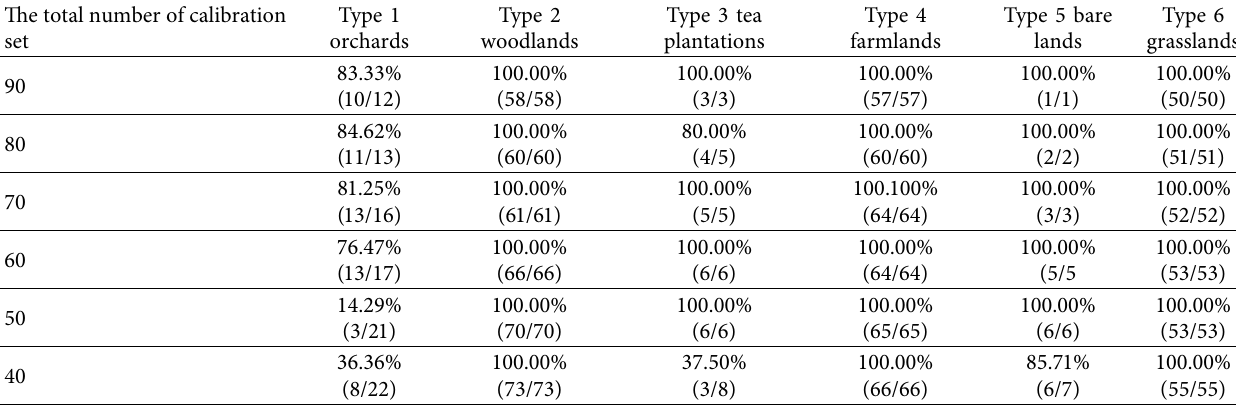
Table 7: The classification results of six types of soil in the test set by support vector